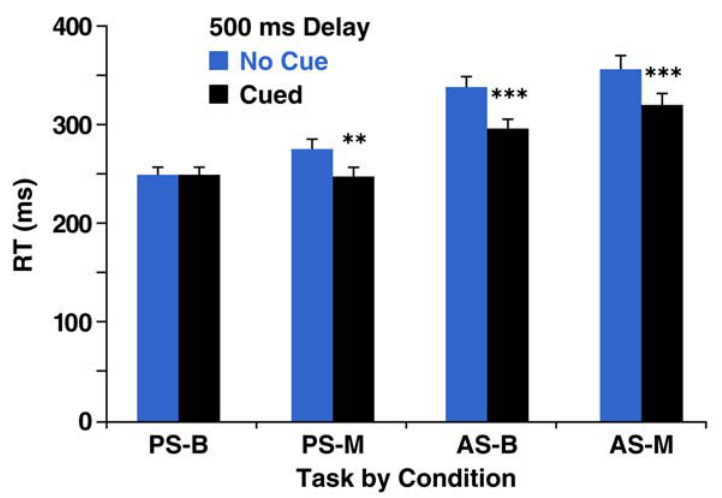
FIGURE 6. Response times, Experiment 3. Mean response times for Experiment 3 (500-ms delay only) for cued vs. neutral trials for prosaccade and antisaccade tasks in mixed and blocked presentations. Cueing effects were significant for all antisaccade trials, but for prosaccade trials only in the mixed presentation. PS, prosaccade task; AS, antisaccade task.